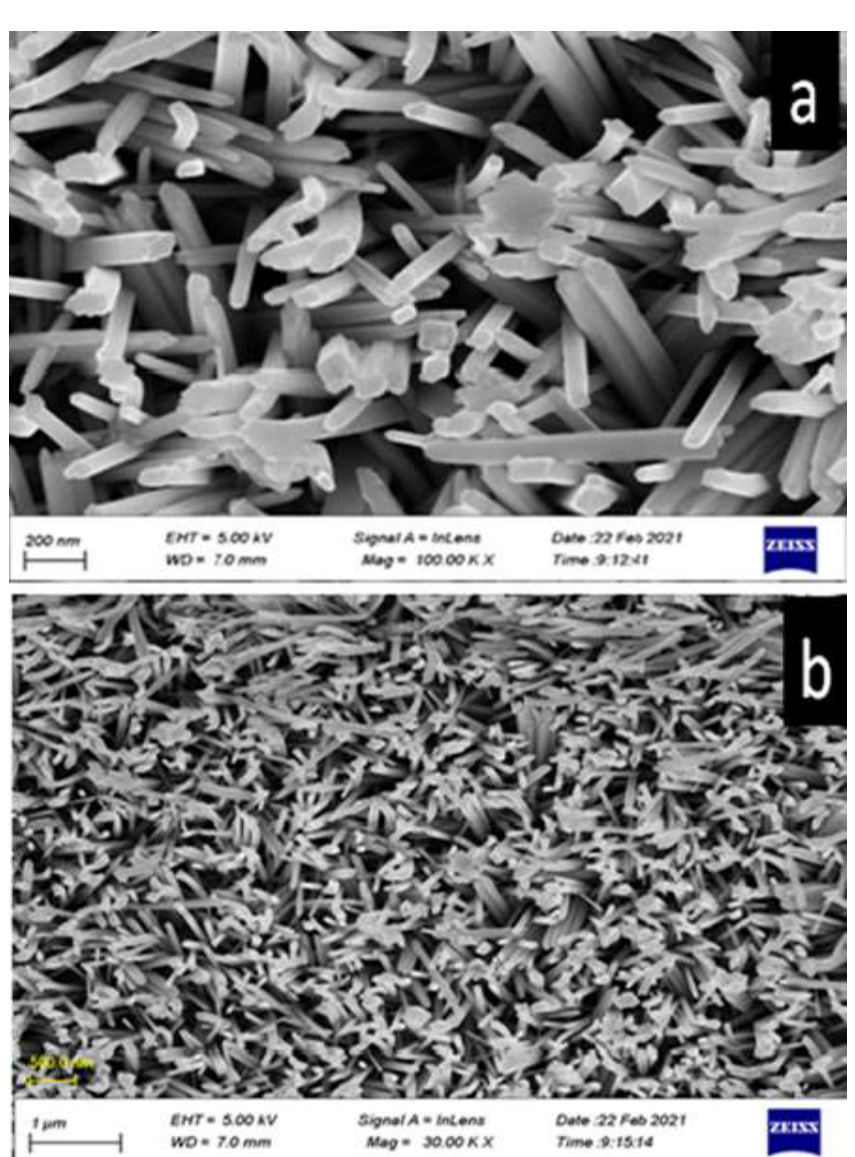
Figure 4 : FE-SEM image for the surface of TiO hydrothermal method 180 °C for 3